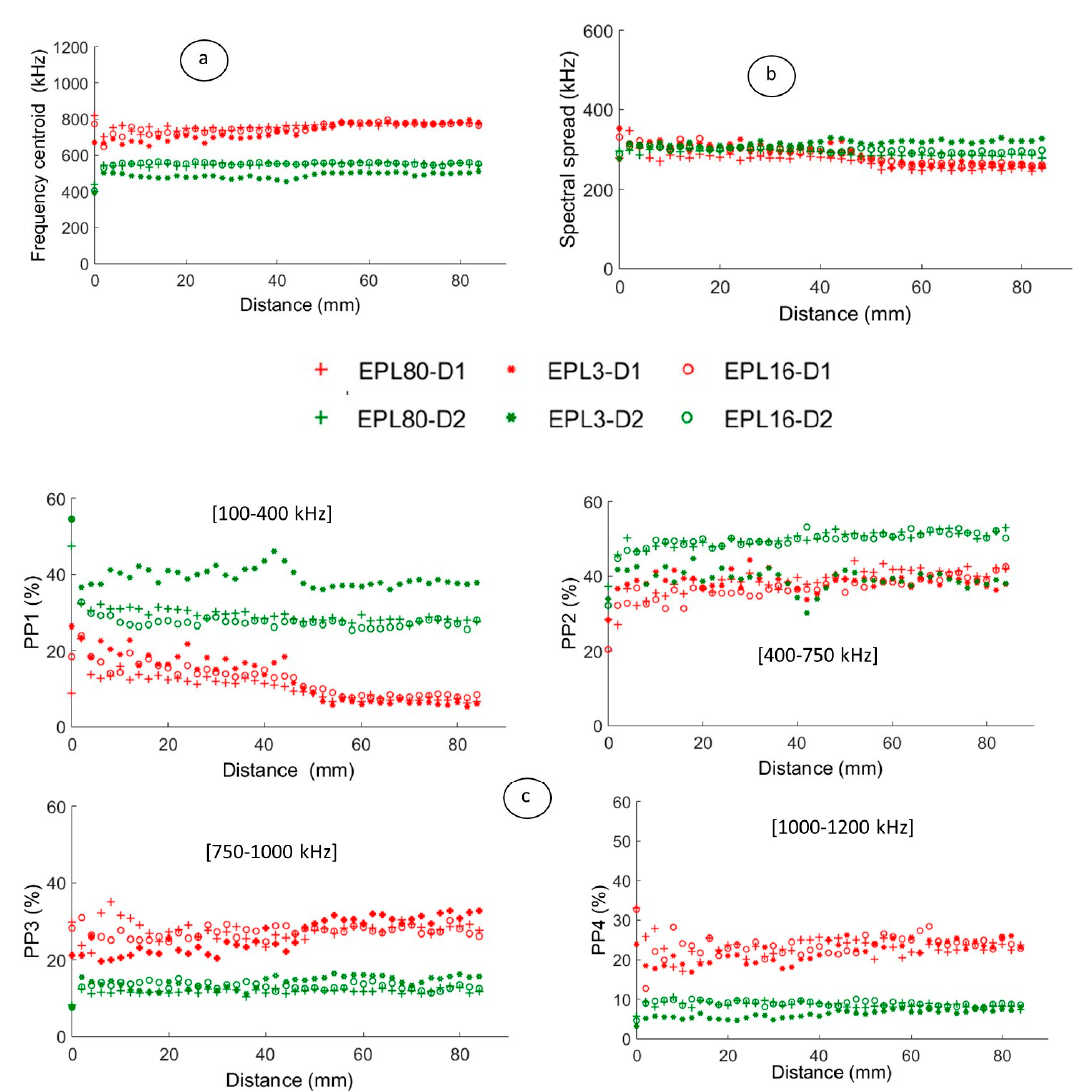
Figure 14. Evolution of parameters calculated in the frequency domain as a function of distance to the source for 3 geometries (EPL80, EPL3, EPL16) and 2 sources (D 1 (M x = 500 N ∙μ m, 0 mm, 0.1 μ s), D 2 (M x = 100 N ∙μ m, 0.95 mm, 1 μ s)): ( a ) frequency centroid, ( b ) spectral spread, ( c ) partial powers.